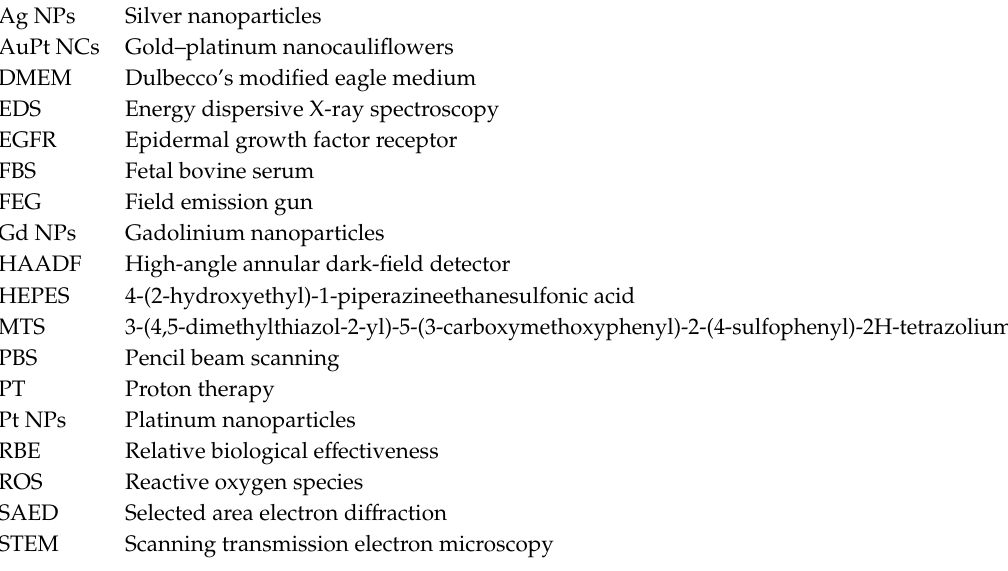
Figure S1: (A) STEM higher magnification image of AuPt NCs, EDS distribution maps of: (B) gold and platinum in the AuPt NCs, (C) gold (yellow) and (D) platinum (red), separately, Figure S2: Determination of the size of AuPt NCs as the distance between two extreme points of these NPs based on STEM HAADF